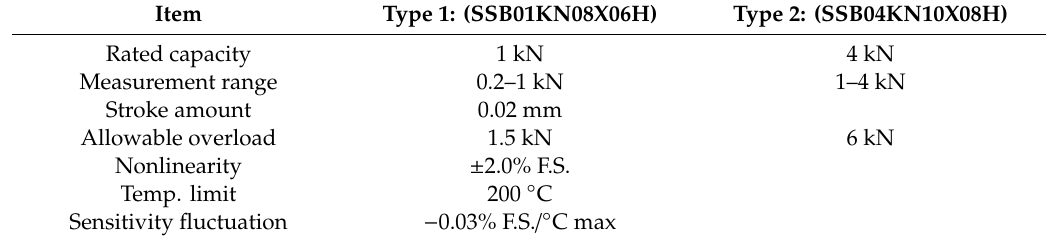
Table 2. Specification of the pressure sensors.